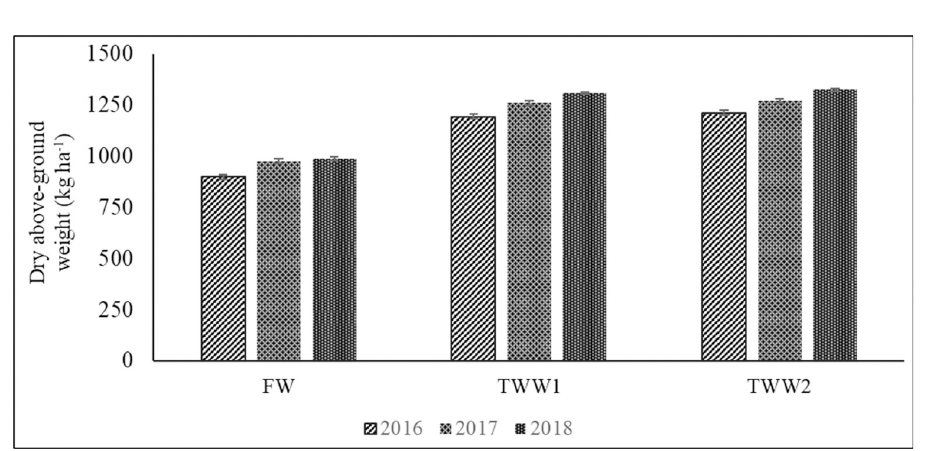
Fig 4. Total herbaceous biomass production in freshwater- and treated wastewater-irrigated plots during 2016– 2018. Bars represent standard deviation.